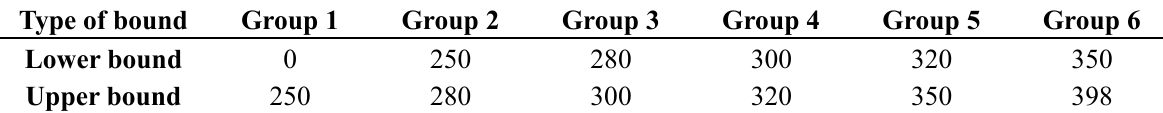
Table 8. Coal consumption interval of each group (kg/MWh).